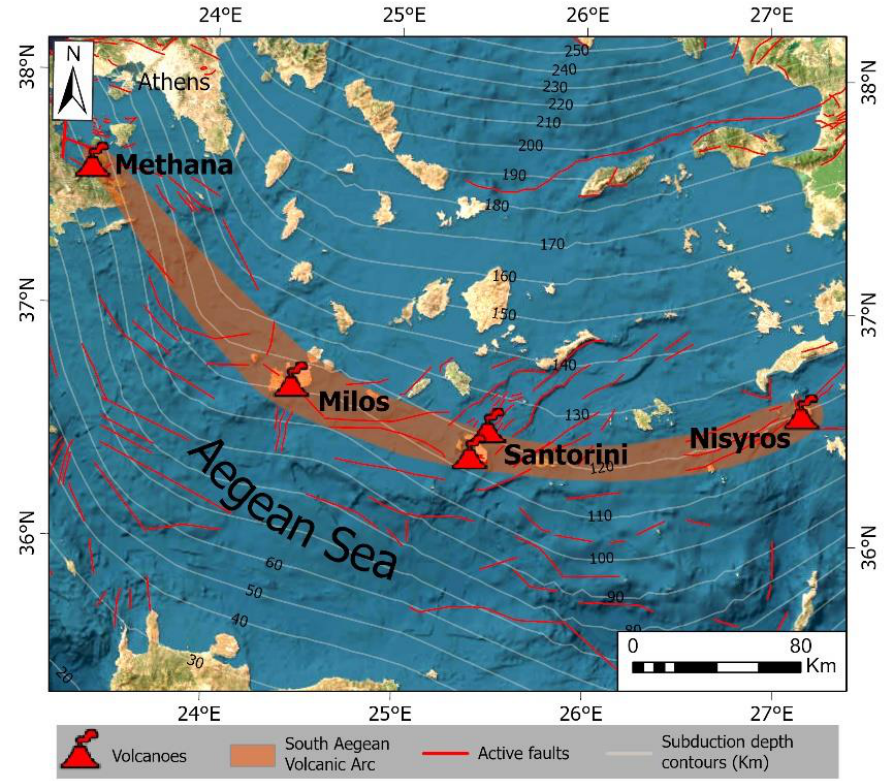
Figure 1. Synthetic topographic Map of the South Aegean Volcanic Arc (SAVA) islands. The SAVA zone is depicted in orange, the volcanoes in red, and the subduction depth contours (km) in white. Basemap source: Esri World Imagery.